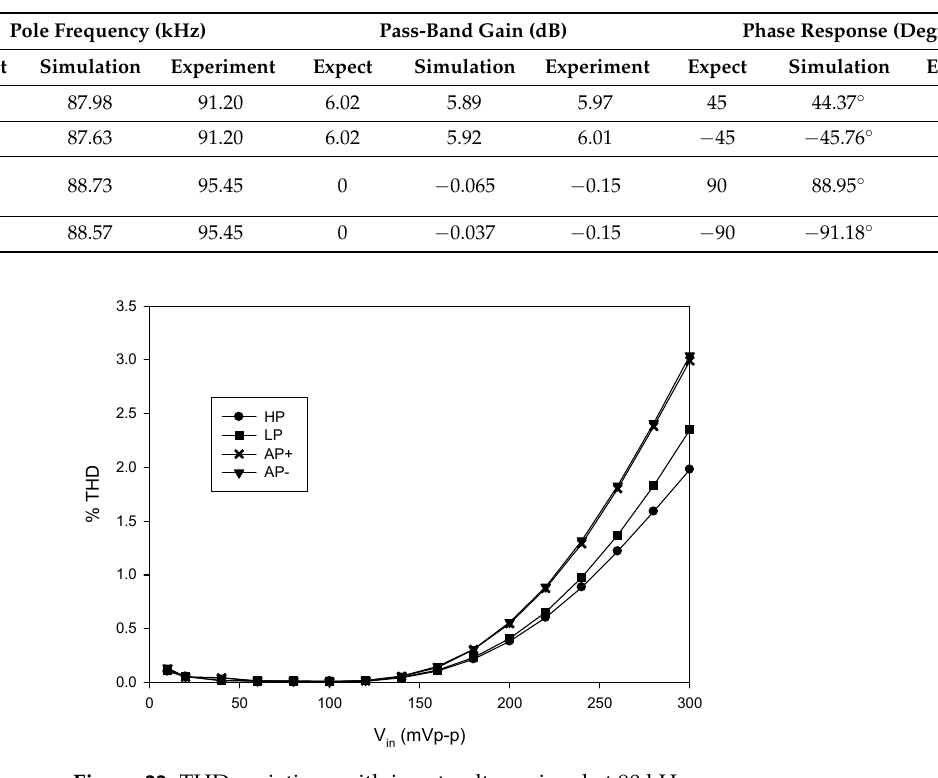
Table 4. The characteristics of the proposed multifunction filter.